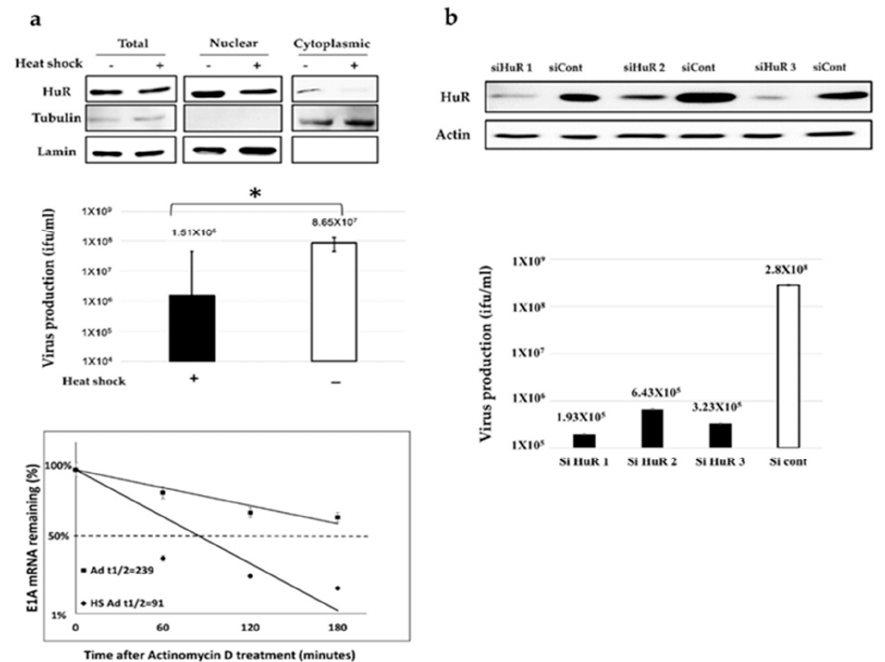
Figure 2. The effects of HuR-depletion on E1A mRNA stabilization and Ad- fos ARE replication. ( a ) HeLa cells were given heat-shock at 43 ˚ C for 2 h, and the amount of HuR in total, nuclear, and cytoplasmic fraction were determined using western blot analysis. β -tubulin and lamin expression were used as cytoplasmic and nuclear fraction markers (top). Virus production was assessed, and the values were compared to the non-treated cells (middle) (* indicates p < 0.05). HeLa cells were infected with Ad- fos ARE (MOI 10 ifu/cell) and heat-shocked immediately after infection at 43 °C for 2 h. Transcriptions were inhibited by actinomycin D 5 µl/mL for 60, 120, and 180 minutes. After the indicated periods, cells were harvested and extracted for total cellular RNA. mRNA levels are quantified by quantitative real-time RT-PCR experiments, using Glyceraldehyde 3-phosphate dehydrogenase (GAPDH) as a normalization control. Graphs depict the percentage of remaining E1A mRNA levels with GAPDH mRNA and compared with the standards of normalized mRNA species measured immediately after the addition of actinomycin D and which were set as 100%. The half-lives of the mRNAs (min) are indicated as t½ (bottom). ( b ) HeLa cells were transfected with a HuR targeting siRNA (HuR 1, HuR 2, and HuR 3) and a negative control siRNA, and the expression of HuR was estimated by western blot analysis. (top) HuR KD-HeLa cells were infected with Ad- fos ARE, and viral titers were determined as described in materials and methods after 48 h of virus infection. (bottom) siHuR, siRNA targeting HuR; siCont, control siRNA treated cells. Data shown above presented as mean ± standard deviation of three independent